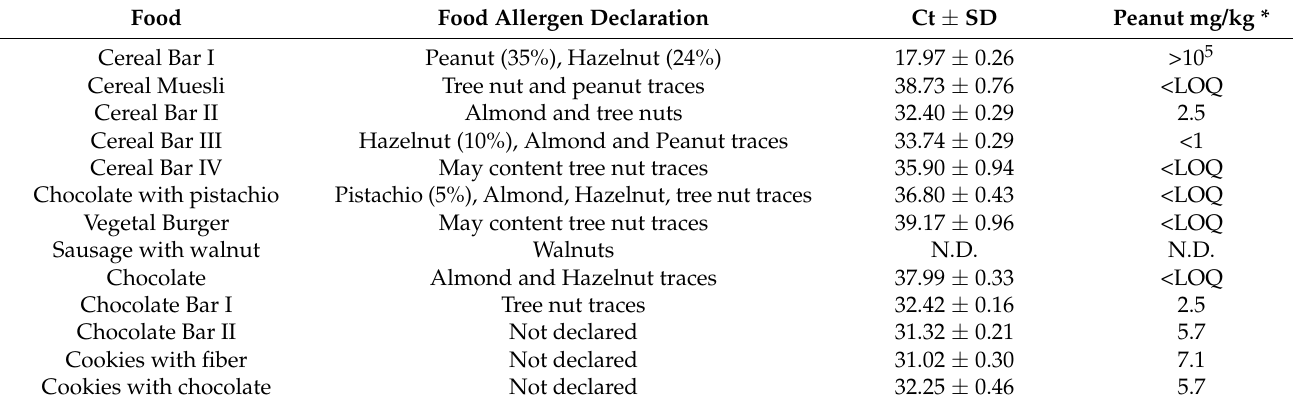
Table 4. Detection of mat K target in several commercial food products by real-time PCR. Mean Ct and standard deviation is shown. Measurements of the same sample were performed at least twice in two different DNA extractions. N.D. means that non-signal after 40 cycles of amplification. All samples were first assayed for amplification inhibitor presence using eukaryotic universal